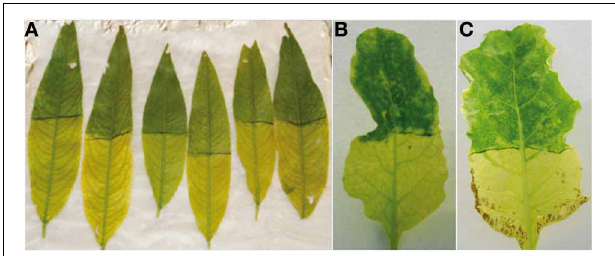
FIGURE 4 | Images of peach tree leaves 8 weeks after the first foliar Fe treatment (A) and two different sugar beet leaves 7 days after the first treatment (B,C). The re-greened areas are the result of treatments with a solution containing 2mM FeSO 4 and 0.1% surfactant.